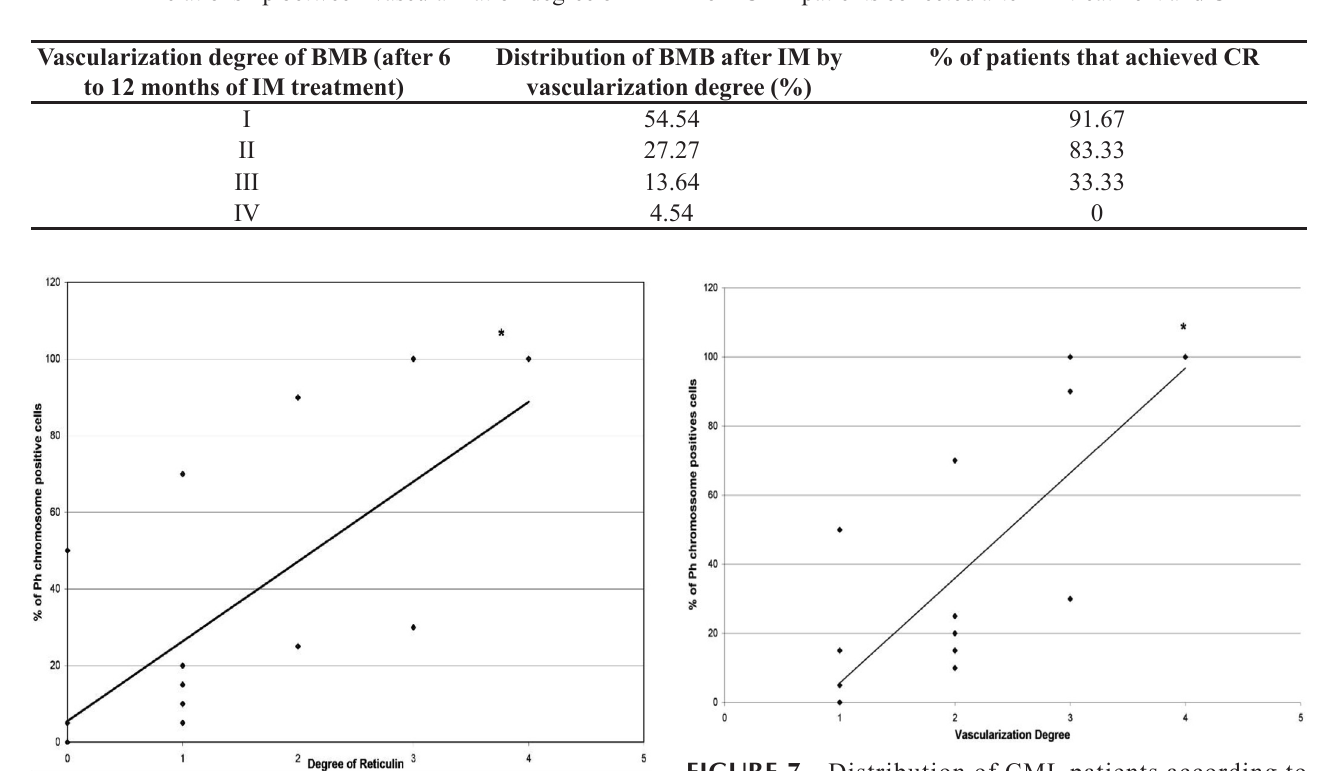
FIGURE 7 - Distribution of CML patients according to vascularization degree on second BMB and percentage of Ph 1 chromosome positive cells obtained in first cytogenetic examination performed after treatment with IM. Points below the line represent patients who achieved CR, while points above the line represent non-responders. This graph was constructed assuming a satisfactory response occurs when there is less than 35% Ph 1 chromosome positive cells on the cytogenetic